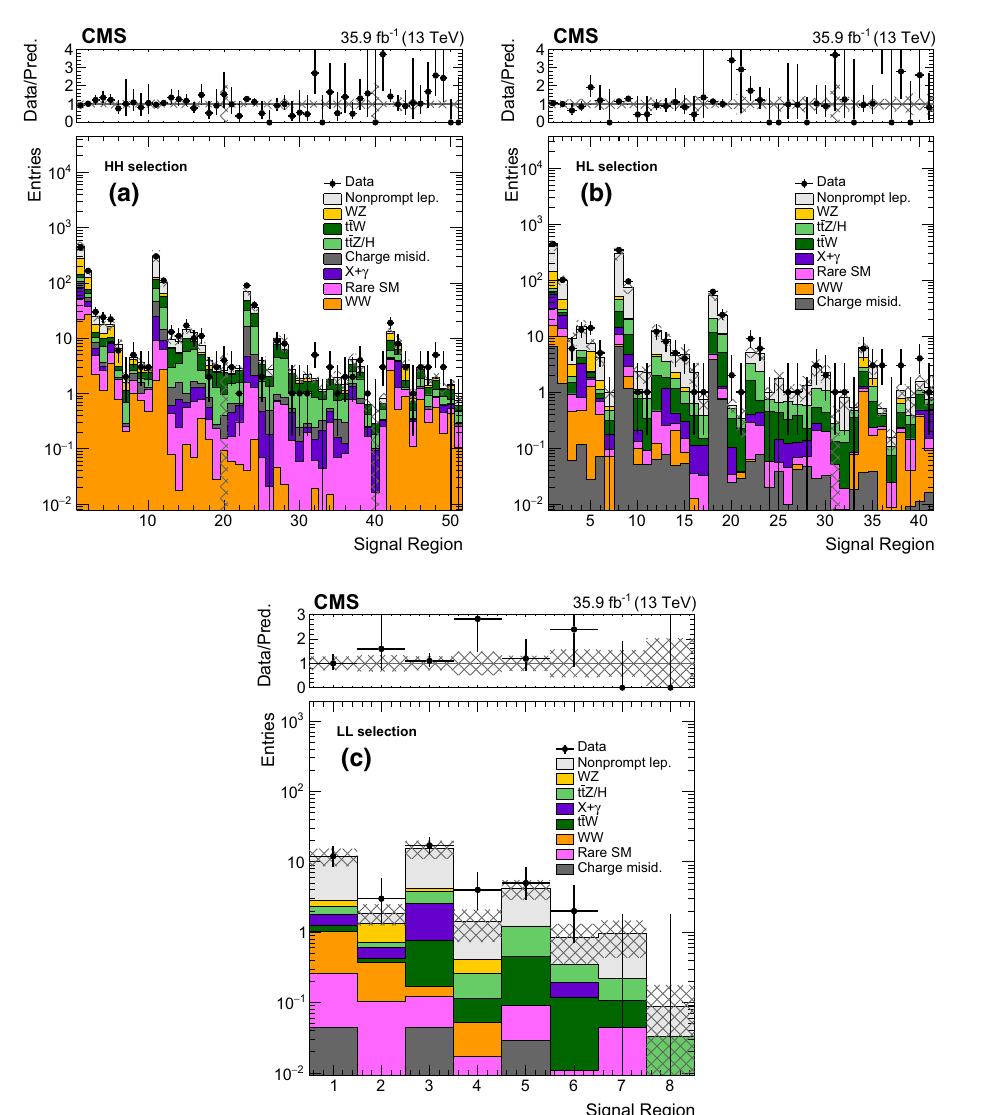
Fig. 4 Event yields in the HH ( a ), HL ( b ), and LL ( c ) signal regions. The hatched area represents the total uncertainty in the background prediction. The upper panels show the ratio of the observed event yield to the background